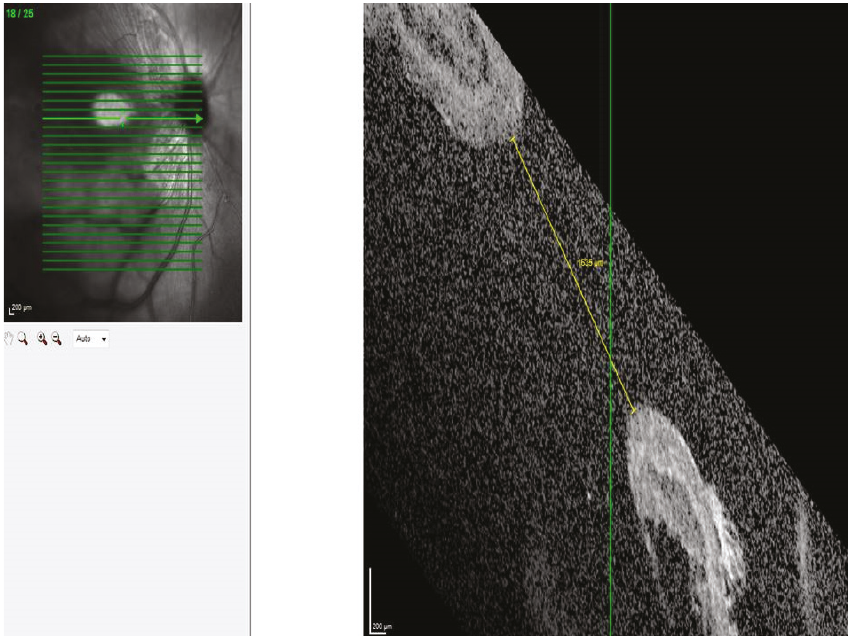
Figure 1: Optical coherence tomography (OCT) demonstrating the size of the large traumatic FTMH. There is an associated foveal retinal detachment around the traumatic macular